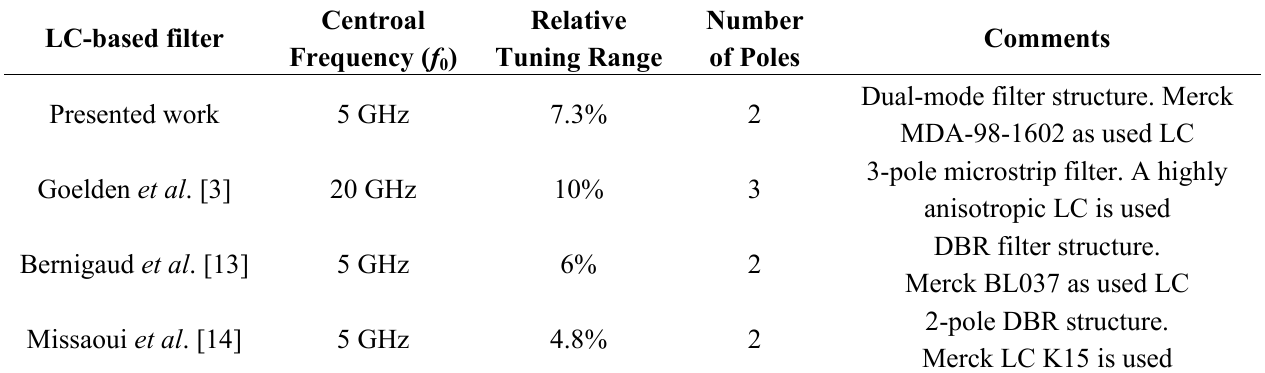
Table 3. Filter performance compared to other LC-based bandpass